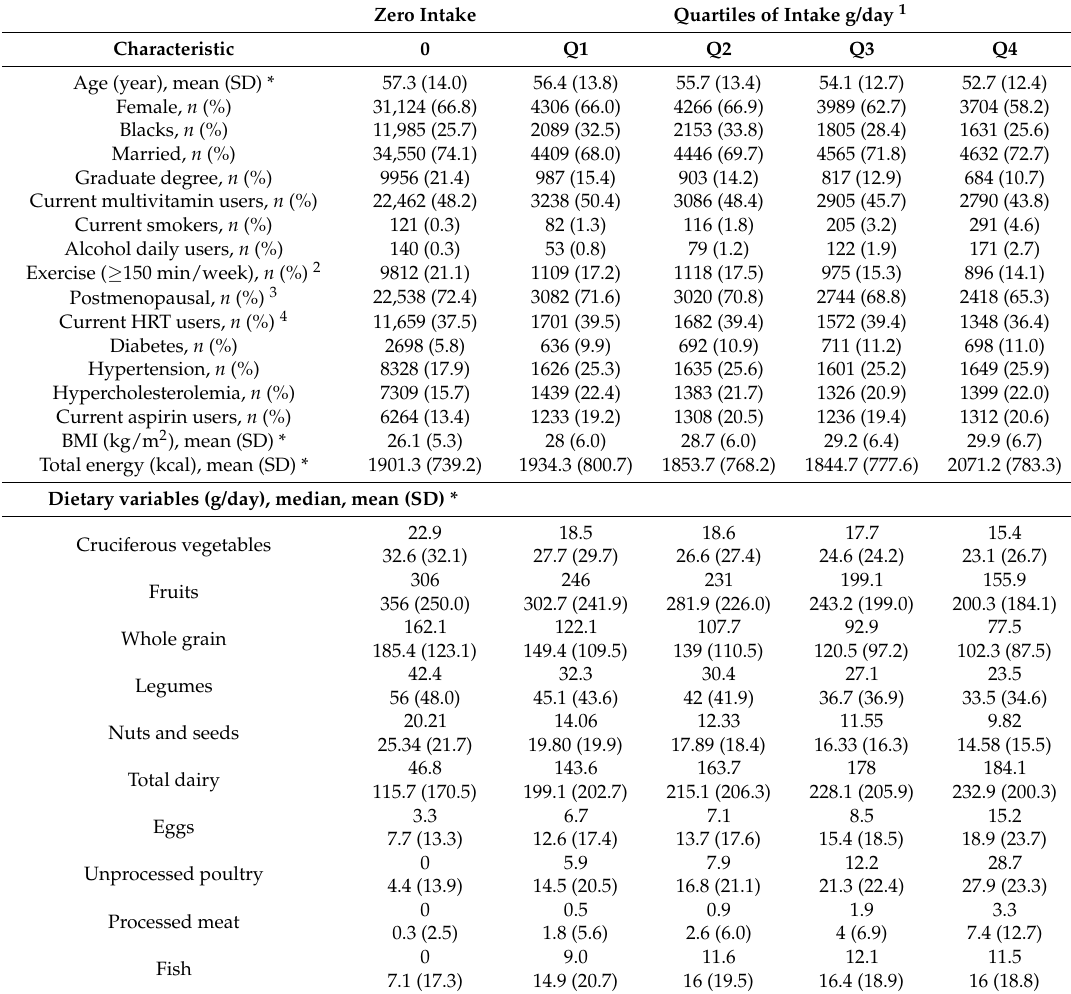
Table 1. Selected characteristics of AHS-2 population by the intake of unprocessed red meat ( N =